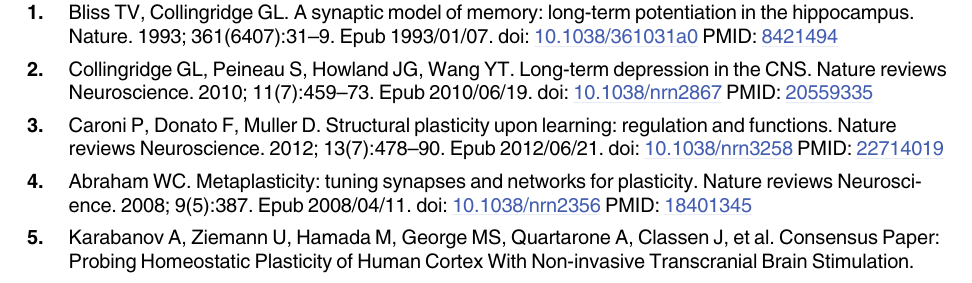
S1 Fig. Figures with individual timecourses of MEP amplitudes after quadri-pulse theta burst